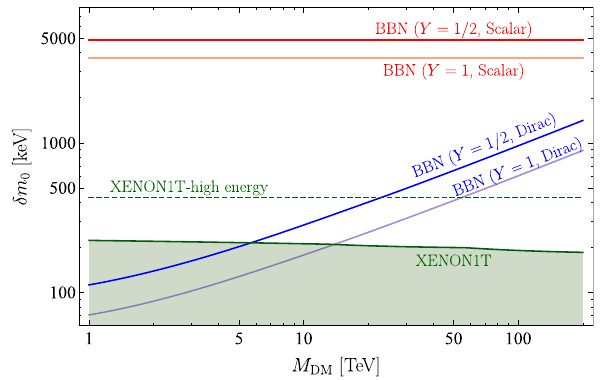
Fig. 1 Summary of the lower bounds on the neutral mass splitting. The dark green shaded region is excluded by tree-level Z -exchange in XENON1T [27] for both scalar and fermionic DM. The dashed green lineshowswhatXENON1Tcouldprobebyanalyzinghighrecoilenergy data. The blue and red lines are the BBN bounds on the splitting for fermionic and scalar DM